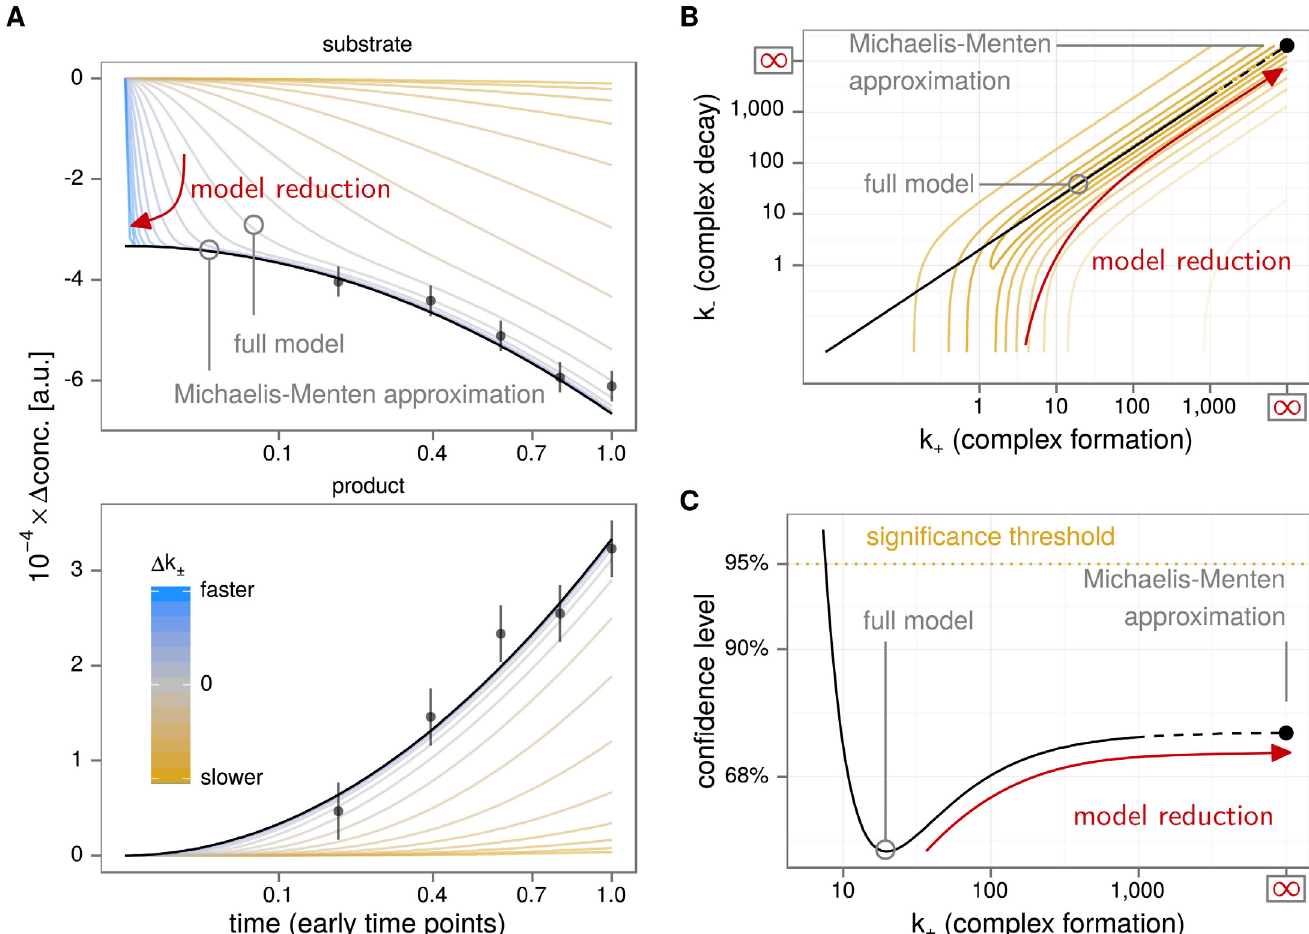
Fig 1. Emergence of the Michaelis-Menten approximation. A: Fast complex formation and decay (blue trajectories) result in the Michaelis-Menten approximation, slow formation and decay (orange trajectories) in a significant discrepancy to the data. B: The path in parameter space leading to the Michaelis-Menten approximation runs parallel to the contour lines of the log-likelihood function. C: The log-likelihood defines a significance threshold, which is not exceeded in the limit of fast formation/decay rates. Slower rates quickly lead to significant deviations from the data.